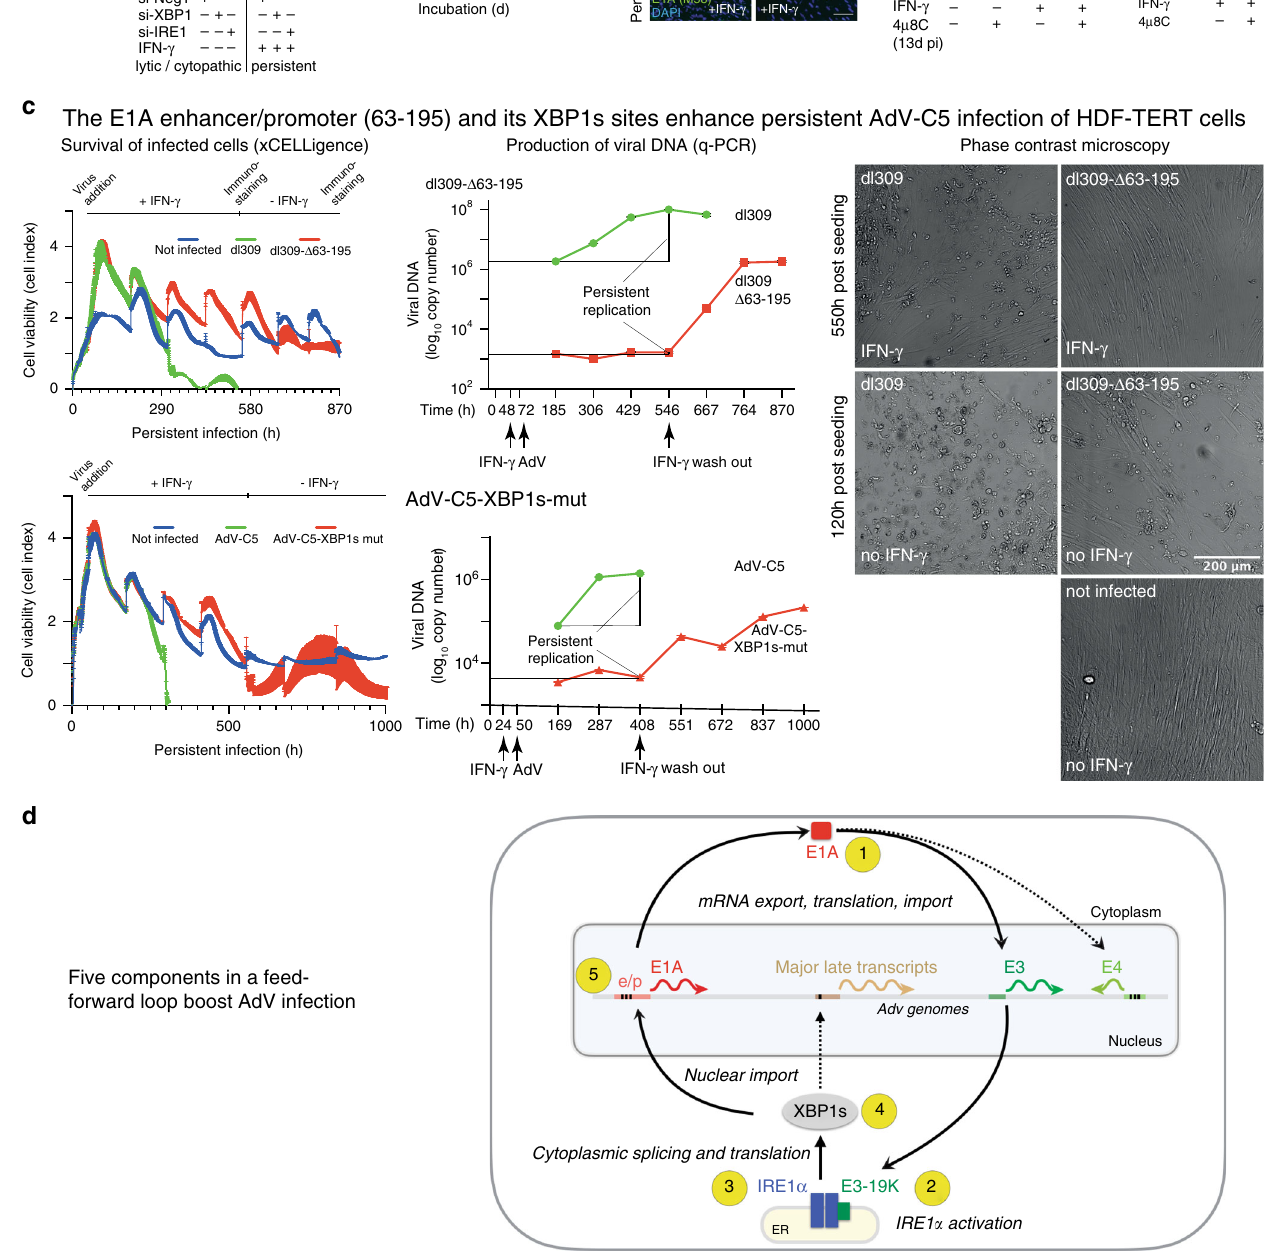
triggers the transition of IRE1 α from a closed to an open con- formation, and leads to IRE1 α oligomerization 65 . Consequences of IRE1 α activation comprise in fl ammatory reactions in con- junction with activation of pattern recognition receptors 66 . The LD of C2 19K and IRE1 α was in close association based on